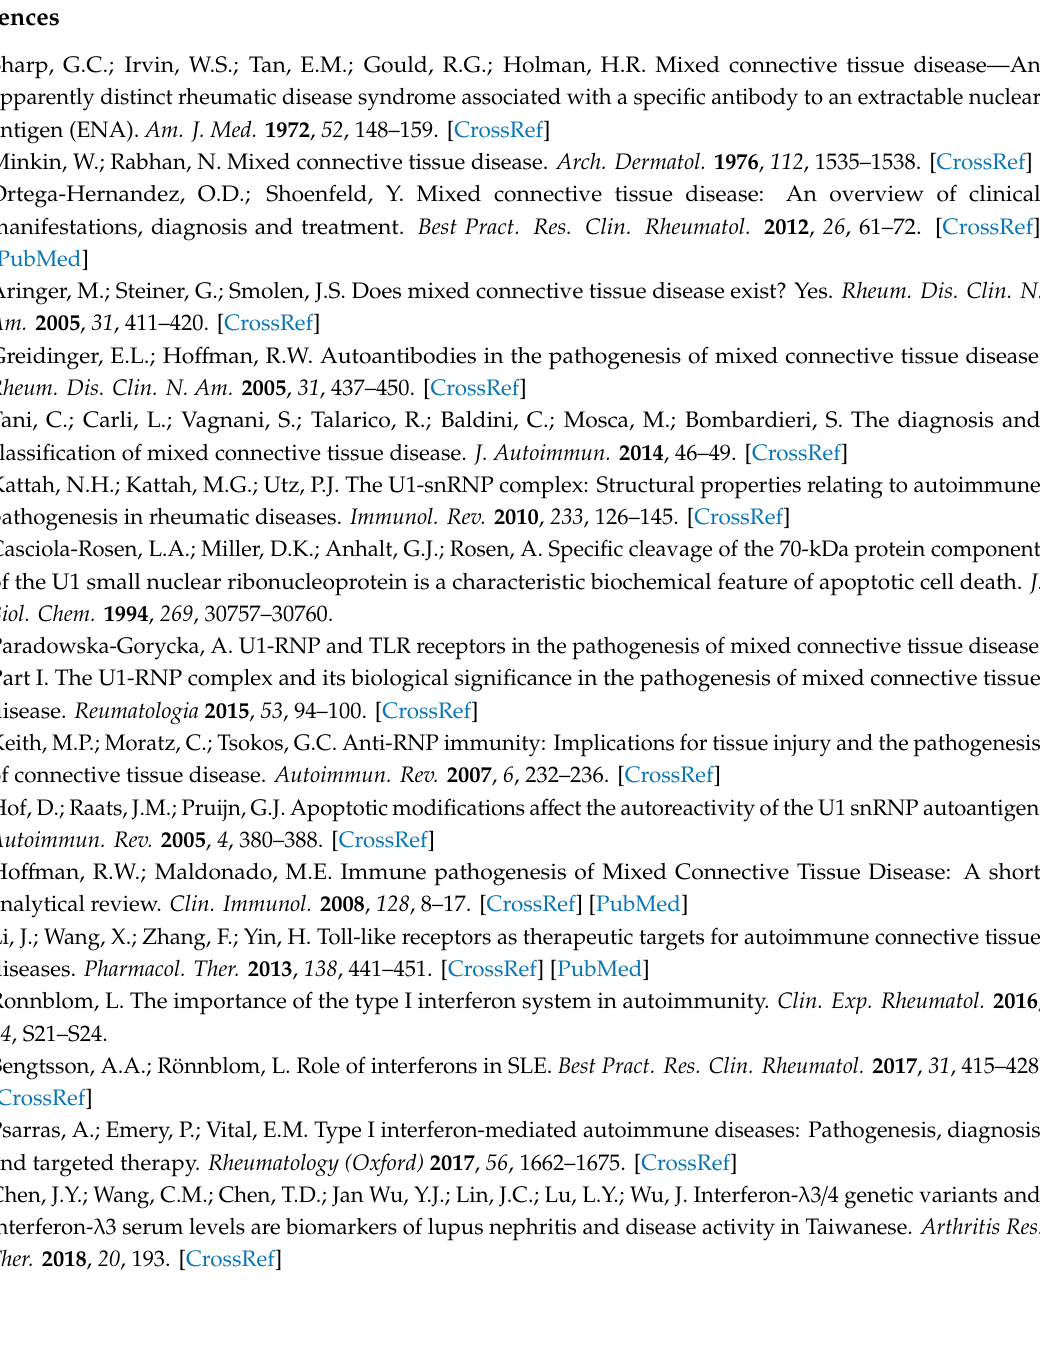
Table S1: Scale of MCTD activity (MCTD-AI); Table S2: Scale of MCTD damage (MCTD-DI); Table S3: SNPs information and genotyping results for MCTD patients and control